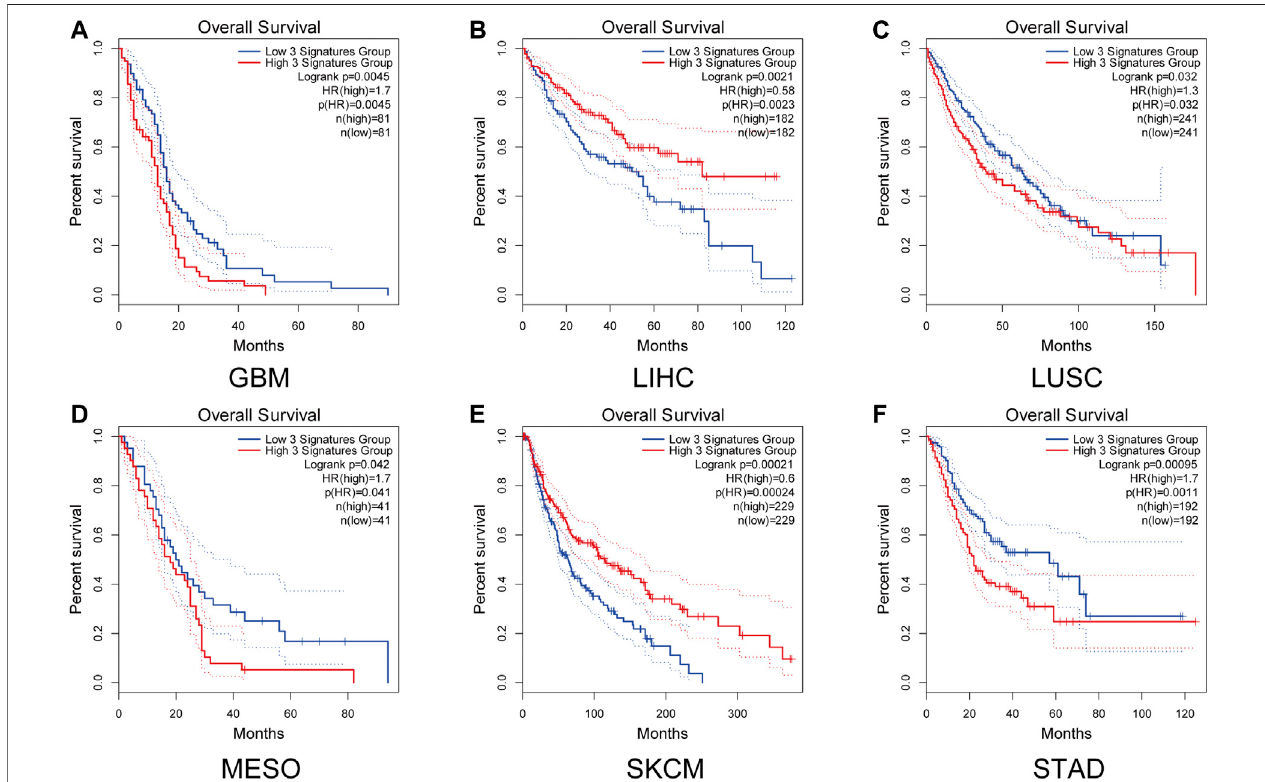
FIGURE 4 | D-Dimer-related genes affect the survival of several types of tumors. (A – F) Kaplan-Meier plots of the three D-dimer-related genes in different tumor types using GEPIA2. p < 0.05 in GBM, LIHC, LUSC, MESO, SKCM AND STAD.